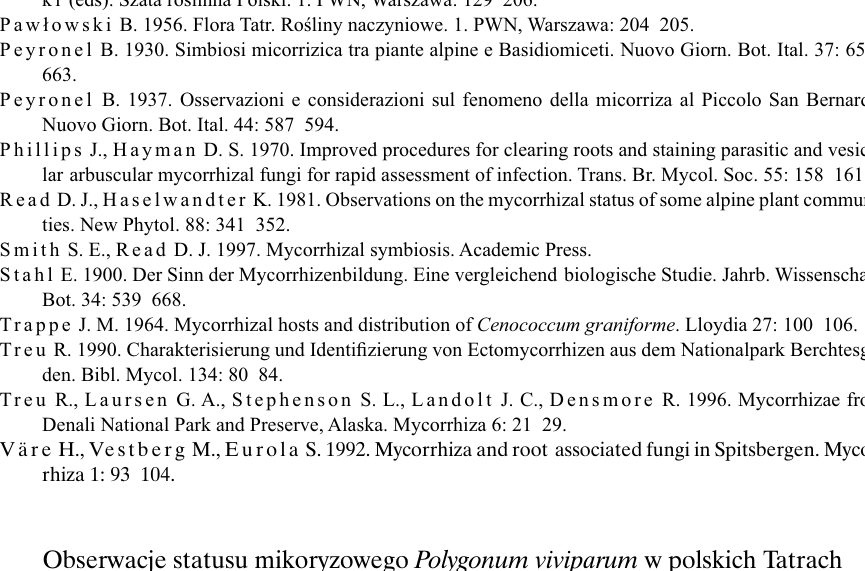
ektomikoryzę. W Tatrach rdest żyworodny należy do gatunków dominujących w piętrze alpej skim, występuje również niżej sięgając do podnóży masywu. Celem badań była wstępna ana liza różnorodności ektomikoryz tworzonych przez ten gatunek w Tatrach oraz ogólna analiza jej zależności od warunków ekologicznych takich jak wysokość nad poziom morza oraz skład zbiorowisk roślinnych. Korzenie P. viviparum były również dodatkowo badane pod kątem obecności kolonizacji